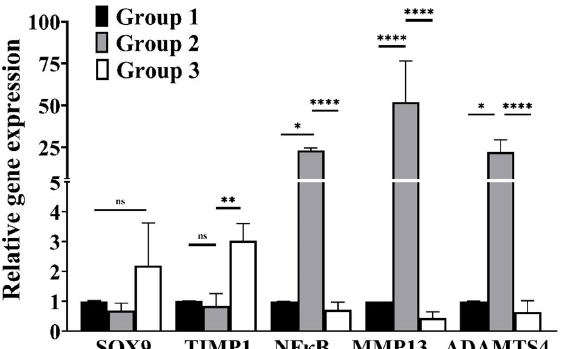
Supplementary Figure S3. Cumulative results demonstrated that cLIUS promotes the gene expression of anabolic markers in the presence of proinflammatory cytokines by downregulating catabolic genes MMP13, ADAMTS4, and NFκB.